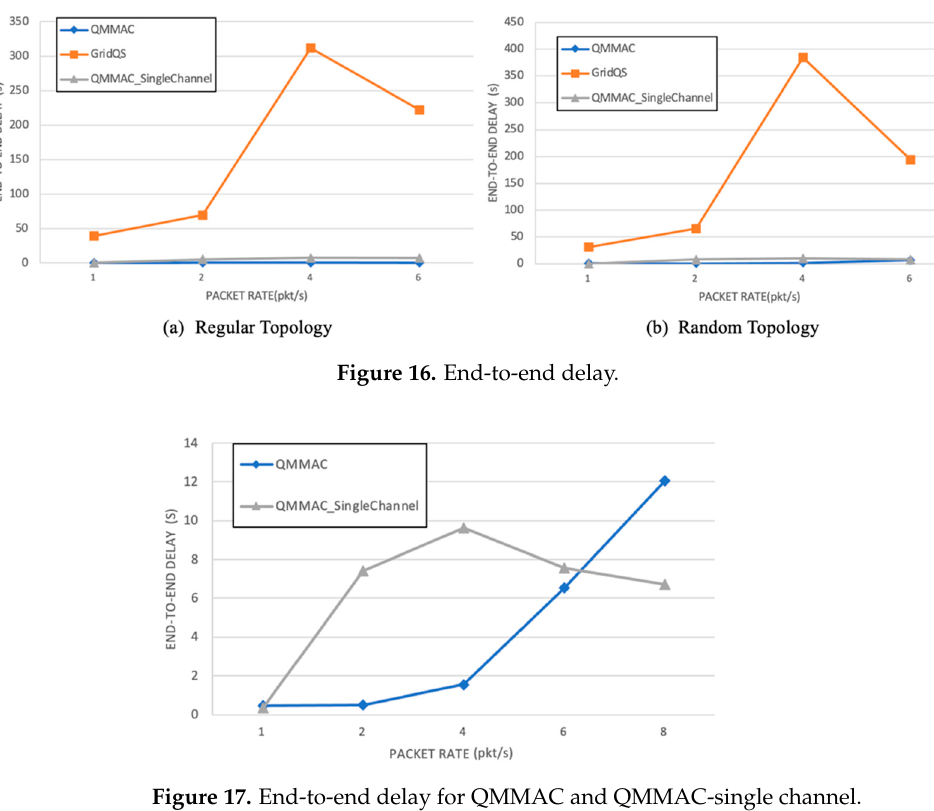
Figure 19. Alive nodes in 𝐶 (cid:2869) . Figure 20. Energy per bit. Figure 21 shows the collision probability on data channels as a function of the traffic rate. By assigning wakeup neighbor nodes a unique slot and a unique channel, QMMAC tries to provide collision-free communications. However, when two non-neighbor down- stream nodes, which use the same channel set, assign the same channel set to two neighbor nodes, a collision may occur at the data channel. These two nodes’ packets may collide if and only if they miss each other CTSs. If a node is busy transmitting on a data channel while its neighbors transmit their CTSs on the shared control channel, the node can miss